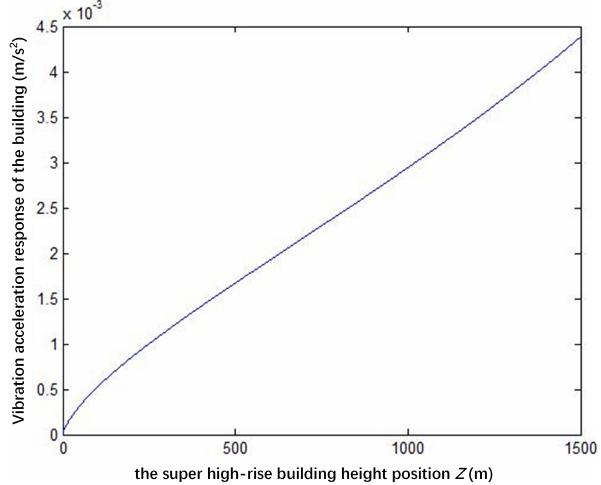
Figure 3. Maximum vibration acceleration curve at each height of the